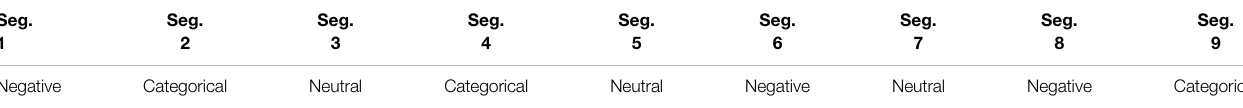
TABLE 1 | Types of images participants saw in the pure regime during each segment. Seg.